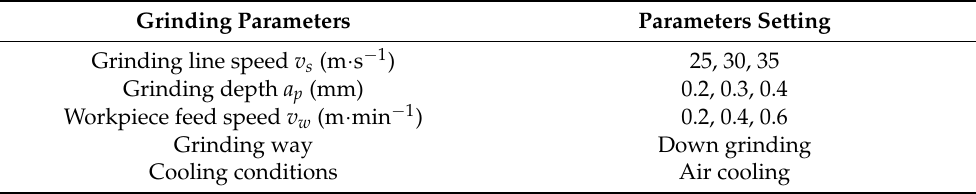
Table 3. Grinding parameters setting of grinding hardening